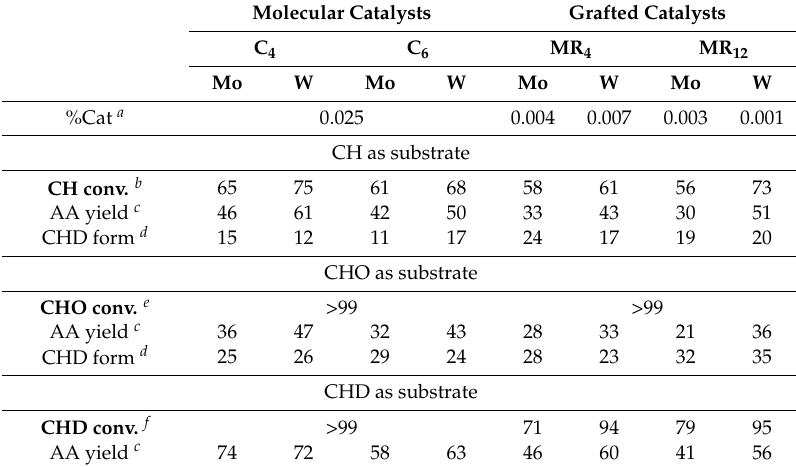
Table 3. Data of oxidation reactions for AA production starting from different substrates (CH, CHO, CHD) and different